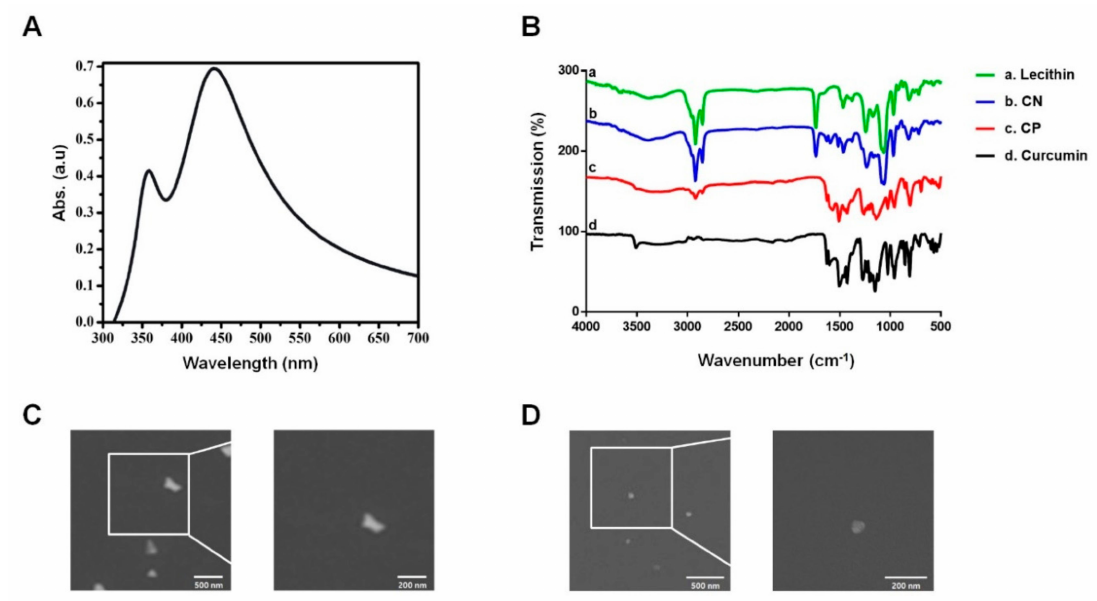
Figure 1. Characterization of curcumin nanosphere (CN). ( A ) Ultraviolet-visible (UV-Vis) spectrum analysis of CN. ( B ) Fourier-transform infrared spectroscopy (FT-IR) analysis of CN. ( A ) Lecithin. ( B ) Curcumin nanosphere. ( C ) Curcumin nanoparticle. ( D ) Curcumin. ( C ) Field emission scanning electron microscope (FE-SEM) analysis of curcumin nanoparticle (CP). ( D ) FE-SEM analysis of CN. n =